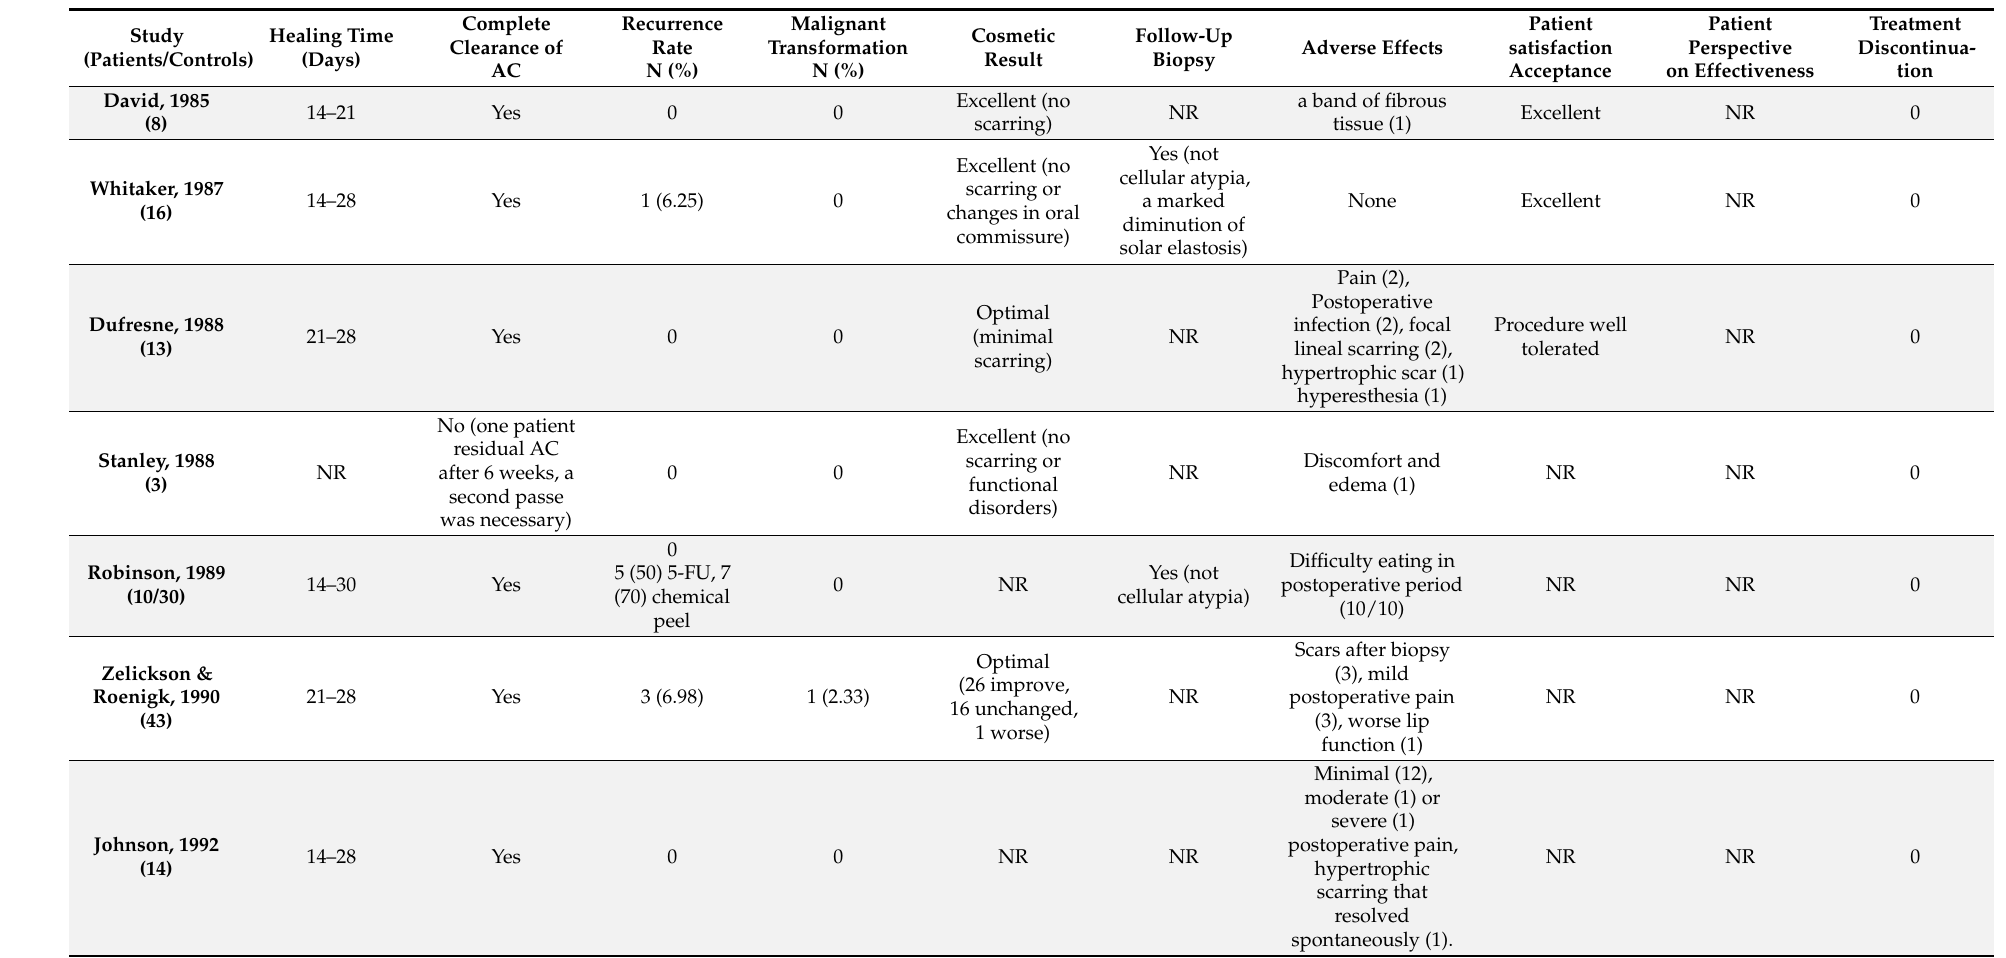
Table 3. Clinical and histopathological data of